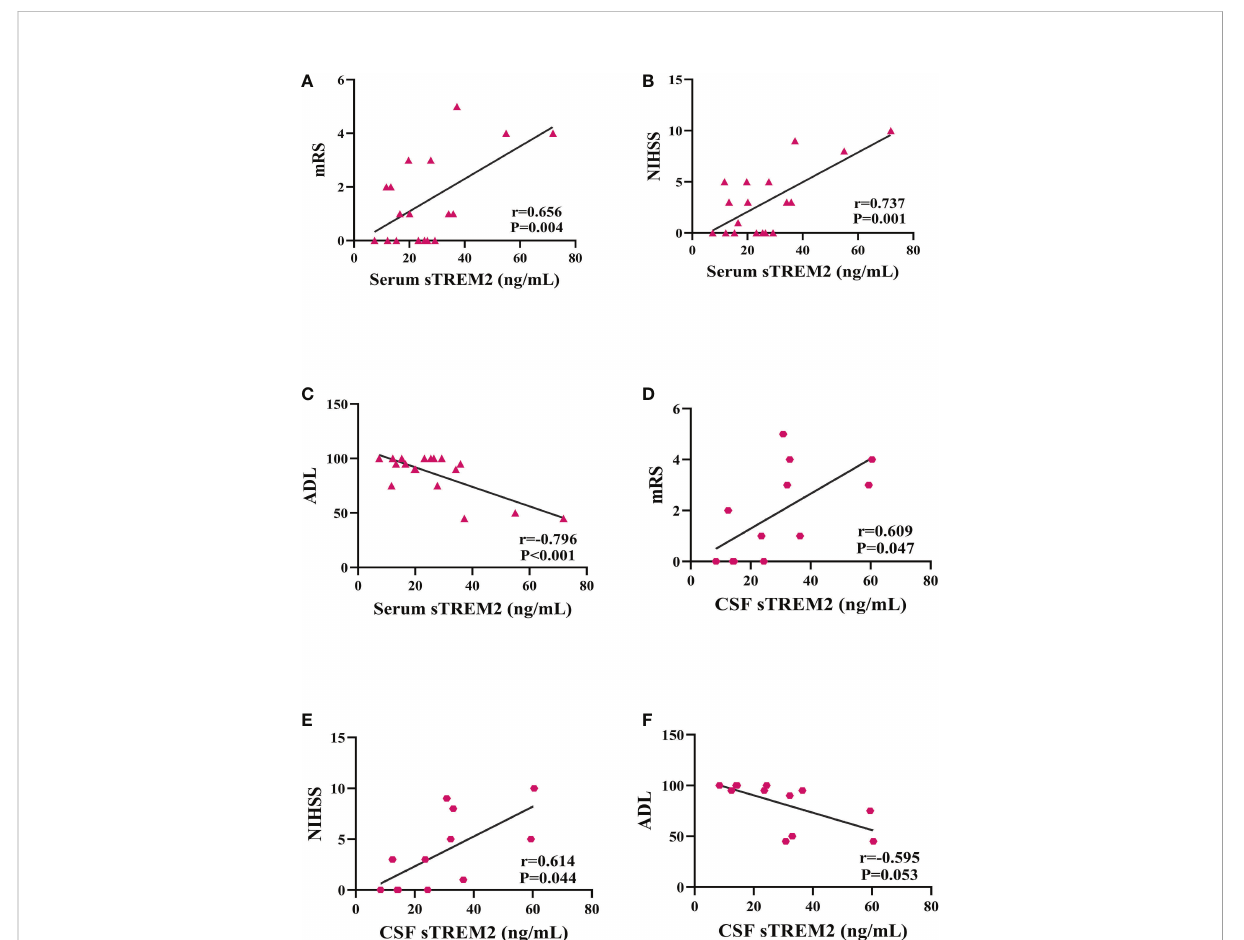
FIGURE 2 Serum and CSF sTREM2 levels were correlated with mRS, NIHSS, and ADL scores as well as outcome at 6-month follow-up in the PACNS group. Partial correlation analyses after controlling for age. (A – C) In serum samples (n=18), positive correlations were found between the serum sTREM2 concentration and the mRS score and NIHSS score, and a negative correlation was found between the serum sTREM2 concentration and the ADL score. (D – F) In CSF samples (n=12), mildly positive correlations were found between the CSF sTREM2 concentration and the mRS and NIHSS scores, and a negative correlation was observed between the CSF sTREM2 concentration and the ADL score.